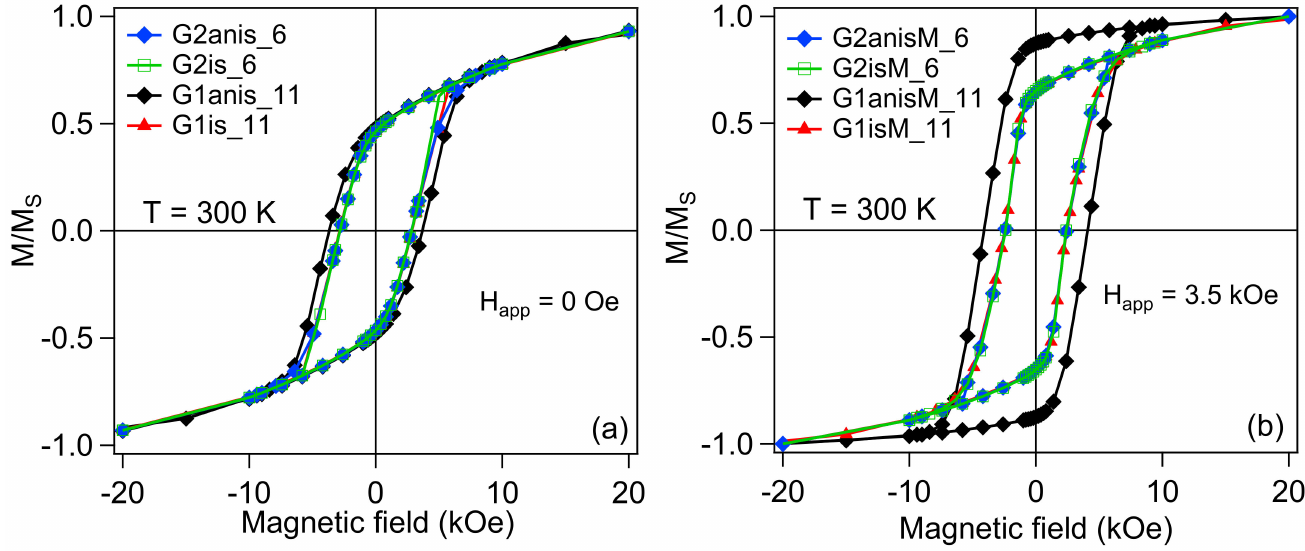
Figure 15. Magnetic hysteresis loops measured at T = 300 K on the indicated composite samples produced with no H APP ( a ) and with H APP = 3.5 kOe ( b ). The loops are normalized to their M S value.